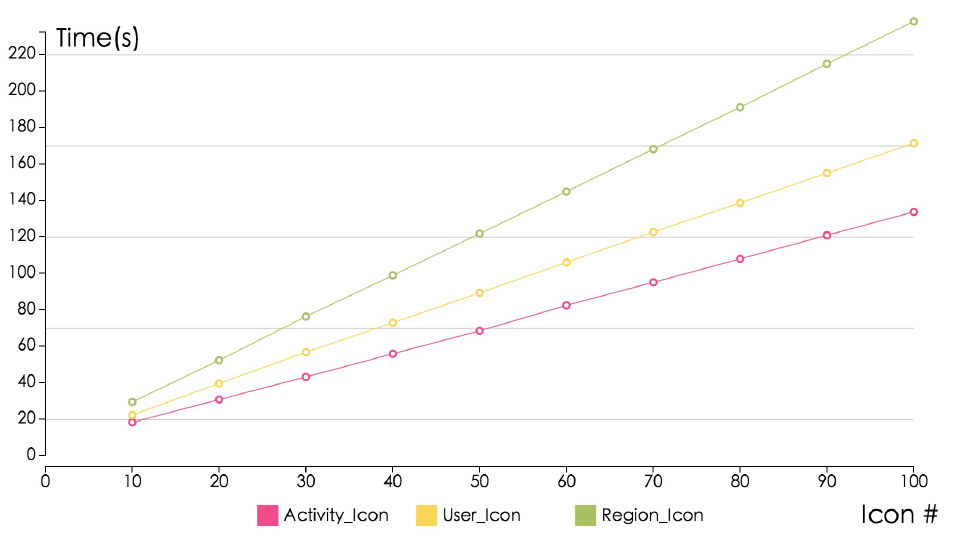
Figure 12. Performance Evaluation. The horizontal axis represents the number of icons generated by our Sci-Fin system. The vertical axis shows the related rendering time and the unit is milliseconds